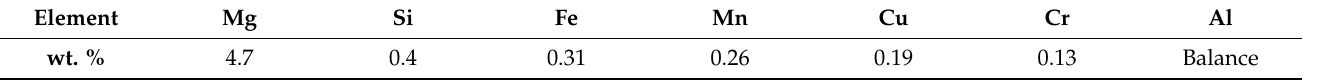
Table 1. Chemical composition of the EN AW5083-H111 aluminum